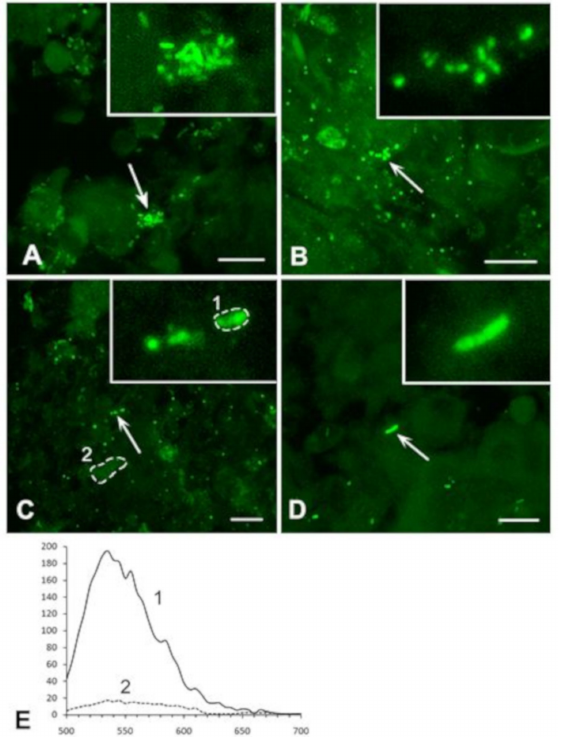
Figure 3. Immunolabelling of M. tuberculosis in lung tissue; the region of caseous necrosis. Small aggregations ( A , B ), colonies ( C ), and solitary bacteria ( D ) were detected. Insets: High magnification of the structures indicated by arrows. Scale bars = 10 µ m. ( E ) The emission spectrum of the fluorescent structure, defined by the dotted line, in ( C ): ( 1 ) Corresponds to the spectrum of the fluorescent marker Alexa-488, while the spectrum of surrounding tissue ( 2 ) is di ff erent. The abscissa shows emission wavelength, nm; the ordinate shows relative